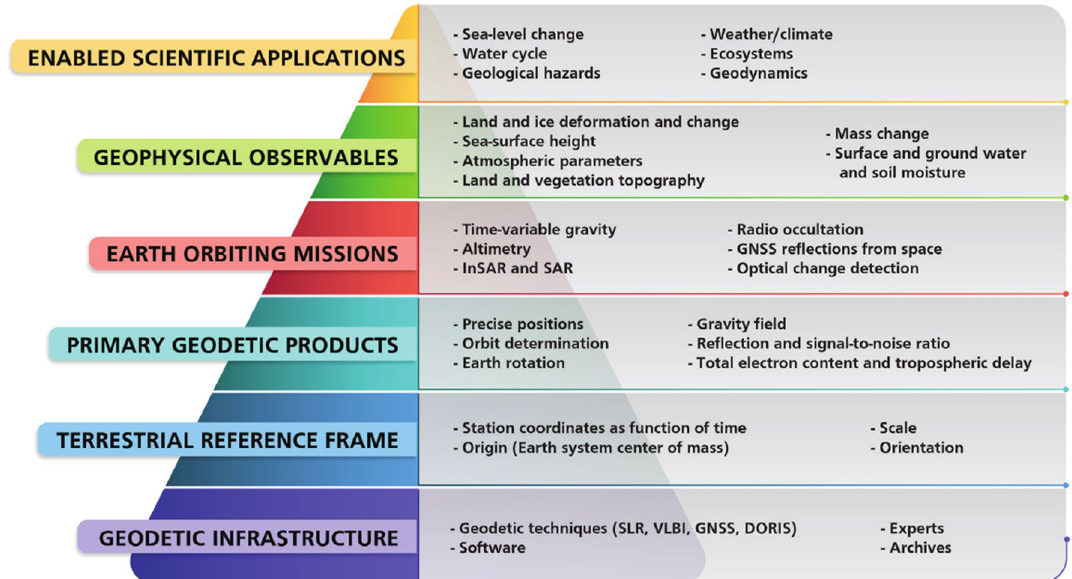
Fig. 9 Illustration of how the geodetic infrastructure is linked to enabled scientific applications (National Academies of Sciences, Engineering, and Medicine